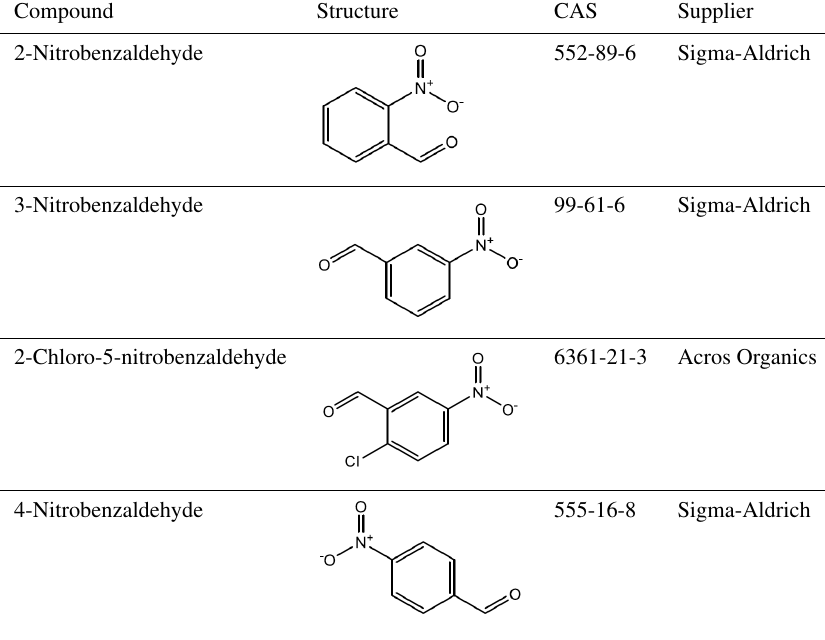
Table 2. Nitrobenzaldehydes measured with the